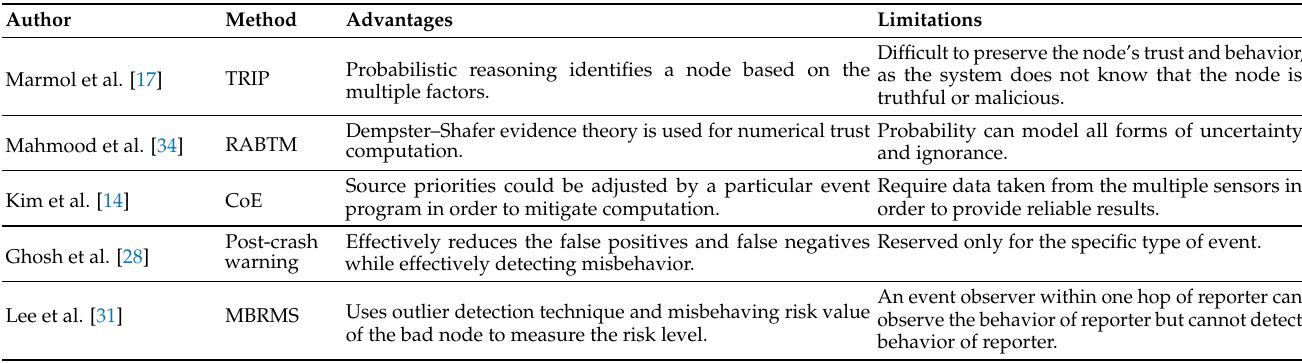
Table 1. Comparison of current bogus prevention